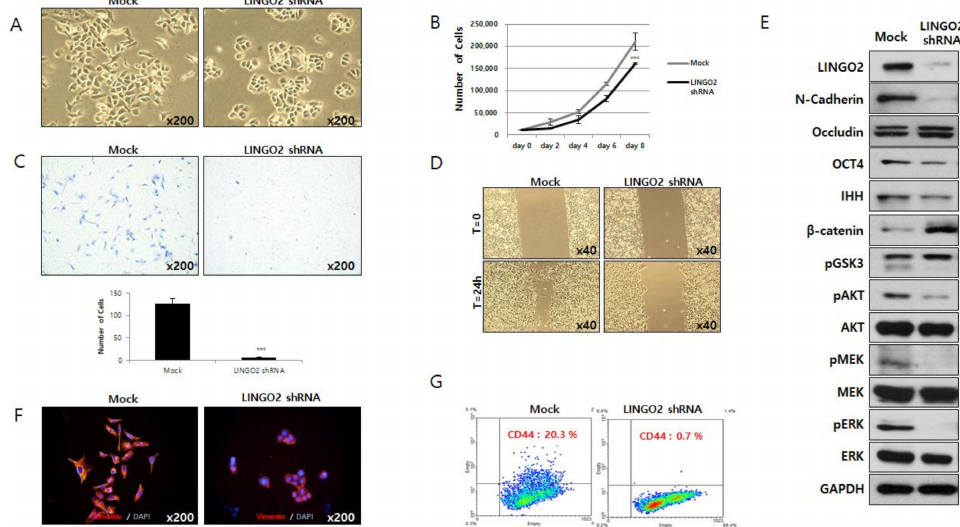
Figure 3. Silencing of LINGO2 reduces cell proliferation, cell motility, and cancer stem cell population. ( A ) Suppression of LINGO2 expression by shRNA changed the cell morphology from tapered ends to rounded ends. ( B ) Cell proliferation decreased by 23.6 ± 9.1% (*** p < 0.001) in LINGO2 shRNA cells. ( C ) Cell migration decreased by 95.5% ± 1.1 % (*** p < 0.001) in LINGO2 shRNA cells. ( D ) When cultures were scratched with a yellow tip, mock cells repaired the wounds in 24 h, but healing was delayed by approximately 6 hours in LINGO2 shRNA-transfected cells. ( E ) Proteins differentially expressed in LINGO2 shRNA-transfected cells were analyzed; stemness-associated proteins including OCT4, IHH, and β -Catenin; AKT/ERK signaling-related proteins including pGSK3, total AKT, phospho-AKT, phospho-MEK, total MEK, phospho-ERK, and total ERK; EMT-associated proteins including N-cadherin and Occludin. ( F ) Silencing LINGO2 decreased the expression of